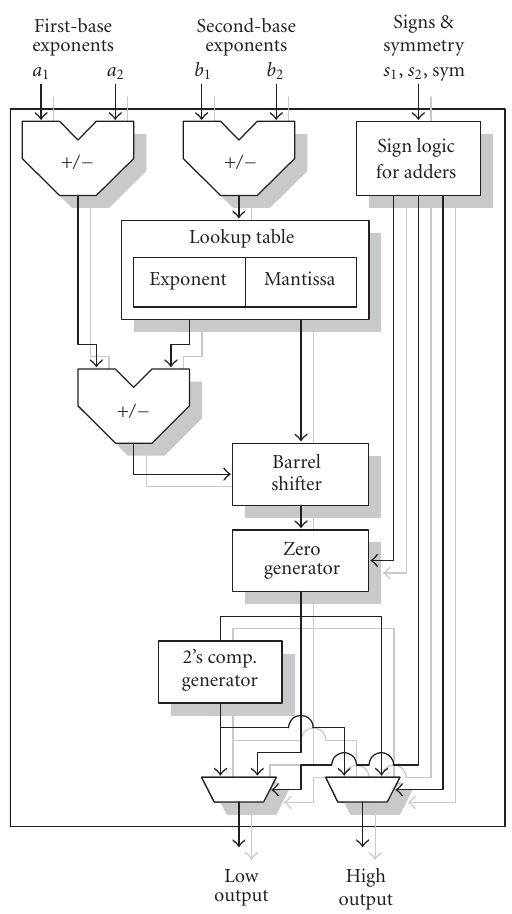
Figure 2: Dual 2DLNS processor for symmetrical filters (w/o accu- mulator).